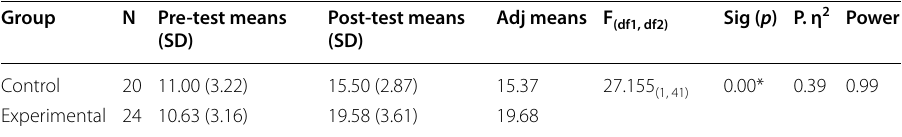
*p < 0.01 Table 4 ANOVA results for each assignment Dependent variable Asgmt. 1